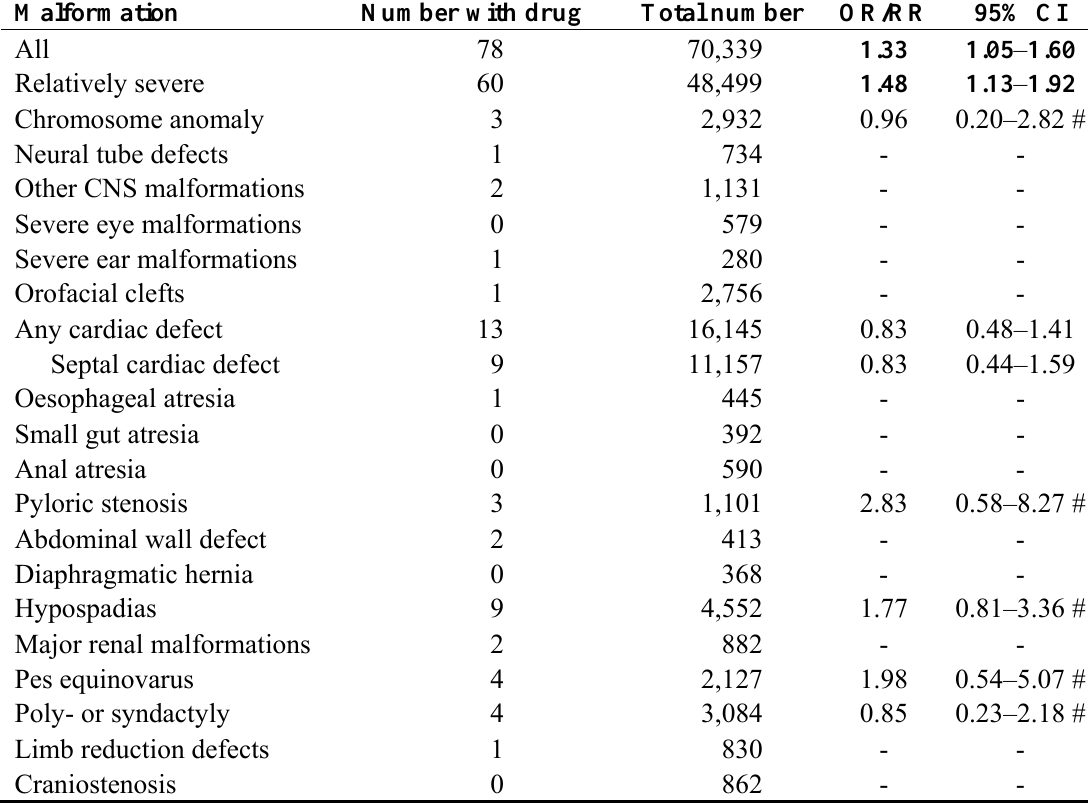
Table 19. Congenital malformations in infants exposed in early pregnancy for neuroleptics other than dixyrazine or prochloperazine. Bold text marks statistical significance.